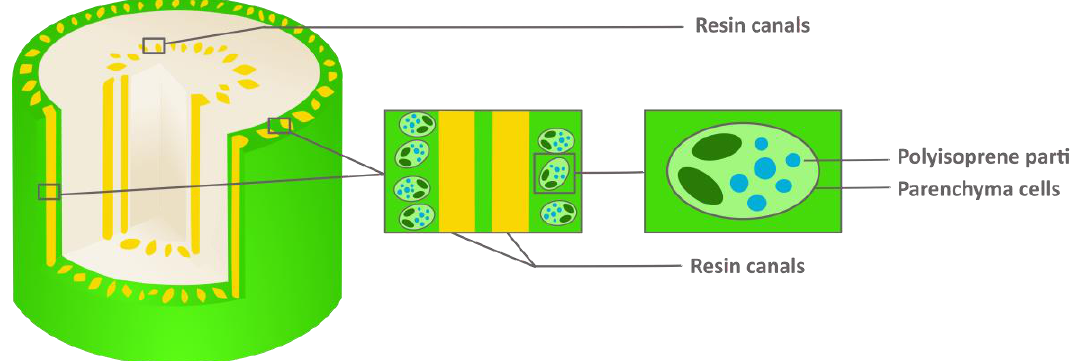
Figure 4: Distribution of polyisoprene and resin in guayule stem Figure 4. Distribution of polyisoprene and resin in guayule